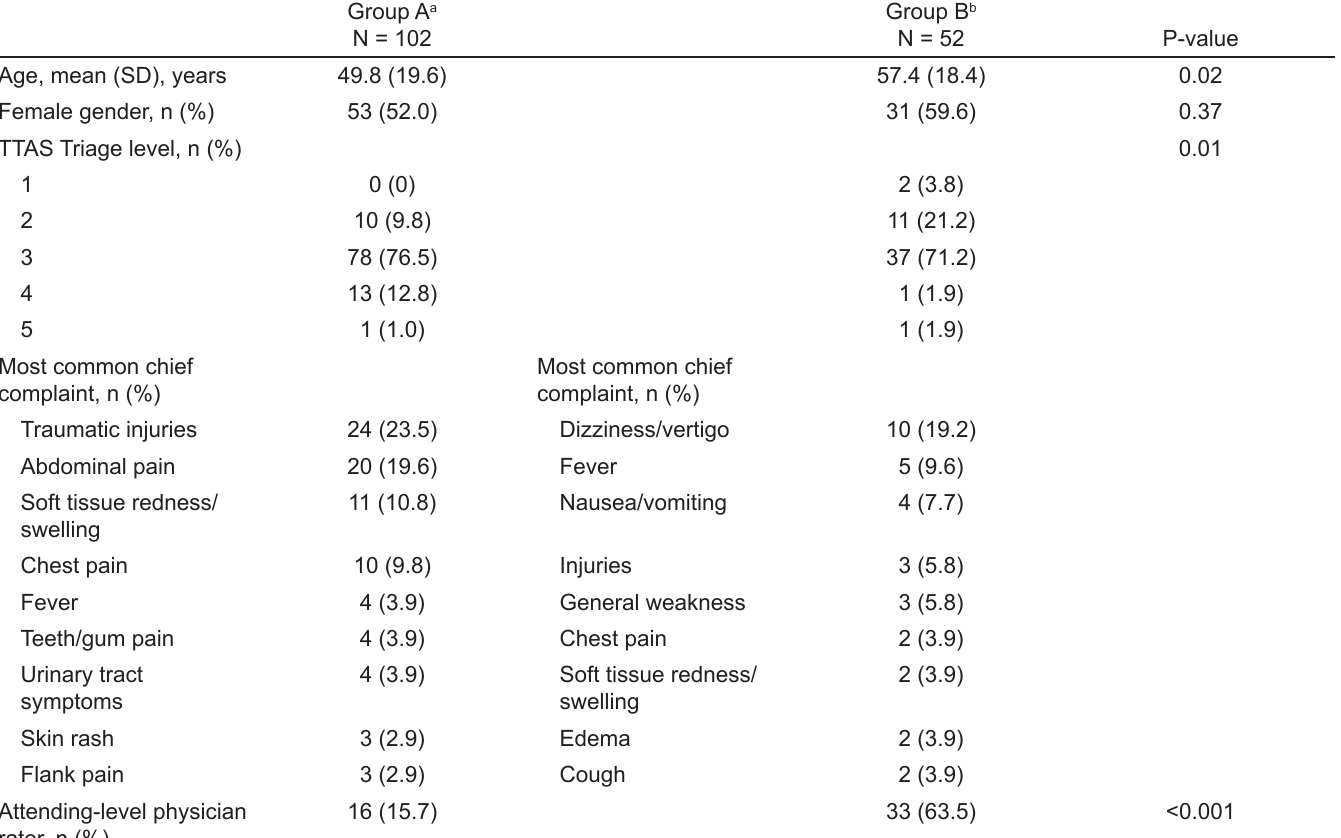
Table 3. Baseline patient characteristics by agreement status of pain scoring.